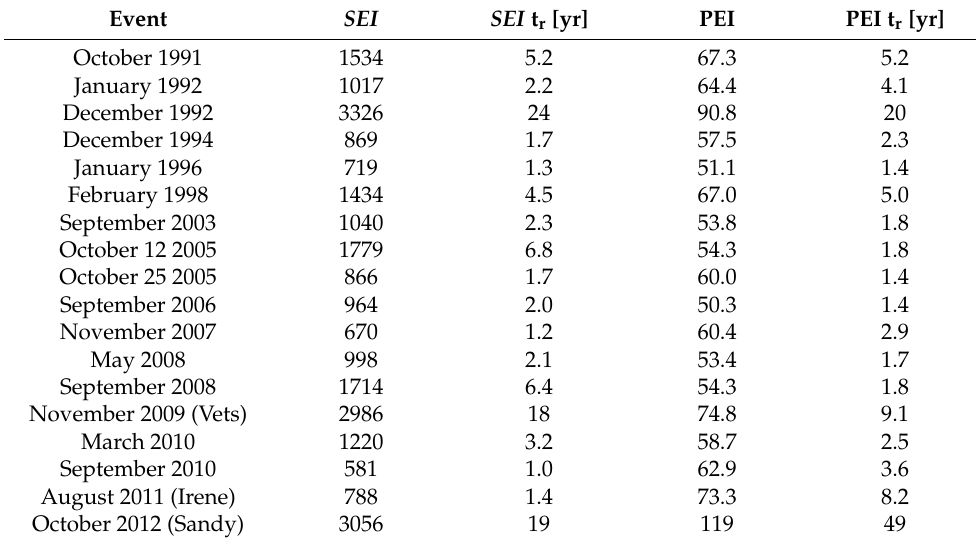
Table 1. Average SEI and PEI values, and associated return periods (t r ), for eighteen historical storms in New Jersey. Return periods are based on frequency of occurrence curves created by Janssen [31]. Event SEI SEI t r [yr]